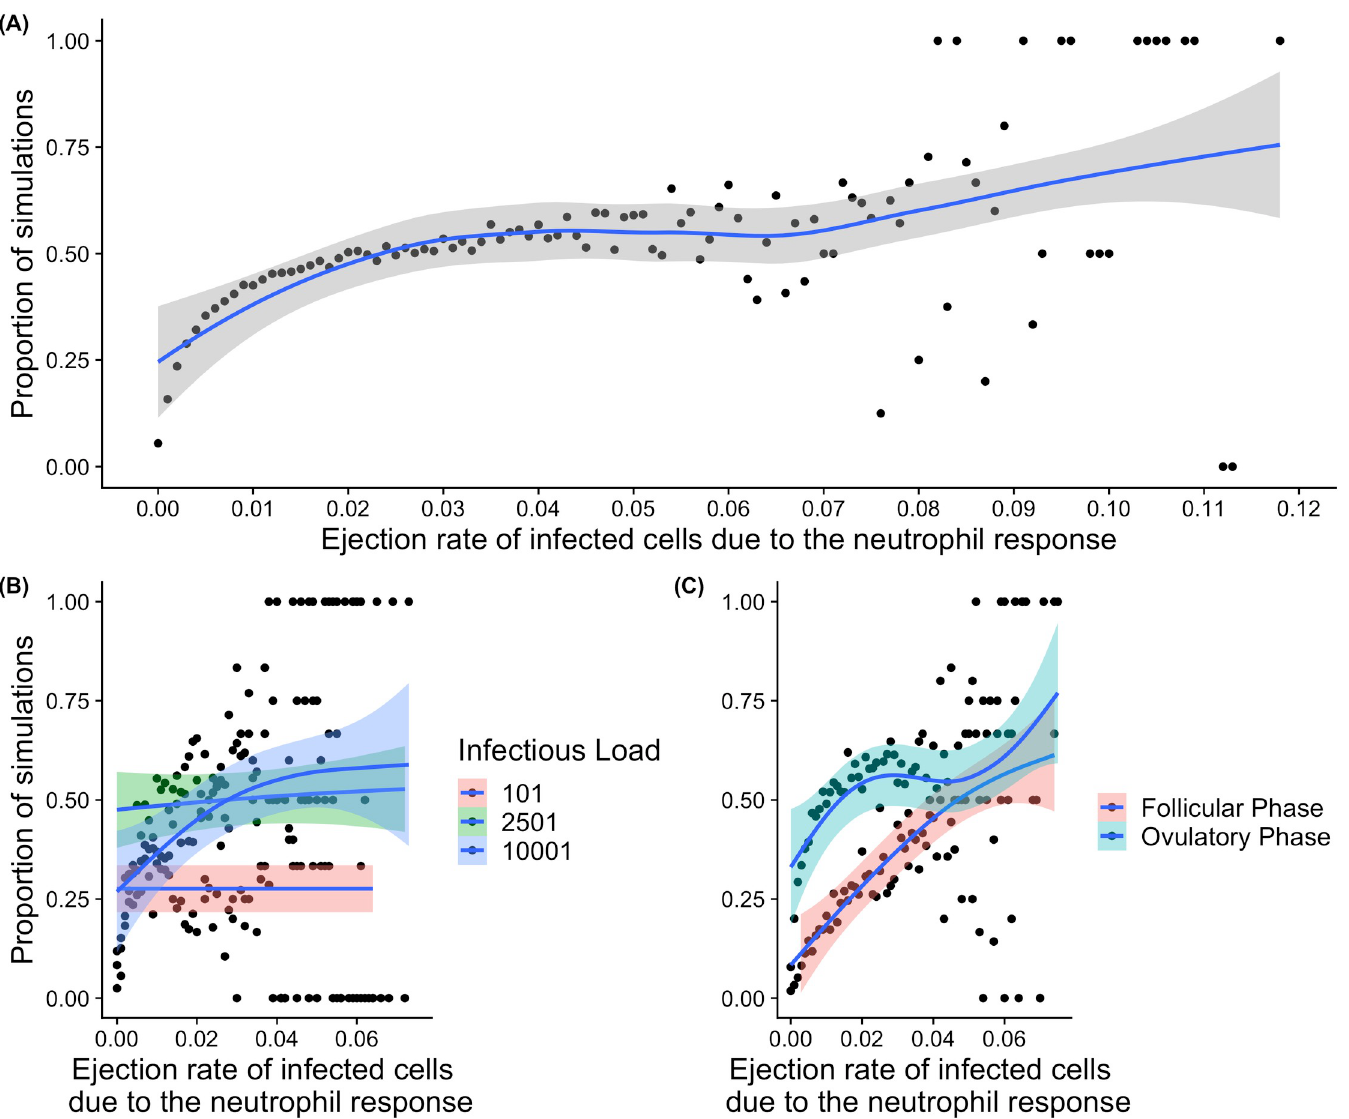
Fig 8. Graphical representation of the proportion of infections that ascend in the simulations from the model and the role of the neutrophil response. The figure shows the proportions of simulations (total of 252, 200 conducted for each instance) where infection was predicted to ascend (y axis). The ejection rate (movement to the cervix from the epithelium) of infected cells related to the neutrophil response (x axis). (A) Ascension and the ejection rate due to the neutrophil response. (B) Impact of initial infectious load (pink represents a low infectious load of 101, green a moderate infectious load of 2501, and blue 10,001). (C) Time of infection relative to the menstrual cycle (follicular phase represented by pink, and ovulatory phase represented by blue). These are simulated over a range of infectious loads (10 simulations at each value of infectious load from 1 to 10001 in steps of 100. In each graph the solid blue line indicates a loess fit to proportion of simulations resulting in ascension, where the shaded area shows is the 95% confidence interval. Each dots are represents simulations at a particular parameter value, from a total of 252,500.